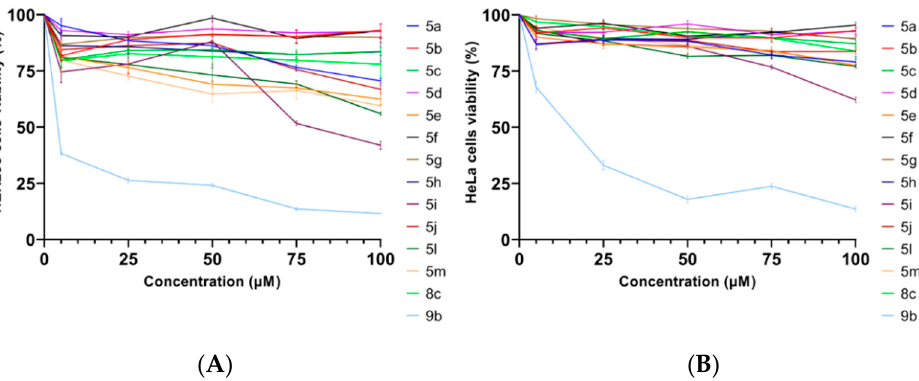
Figure 11. Dose-response curves for HeLa ( A ) and HEK293 ( B ) cells incubated for 24 h with different concentrations of the examined compounds. Data points represent mean ± SD for 4 biological